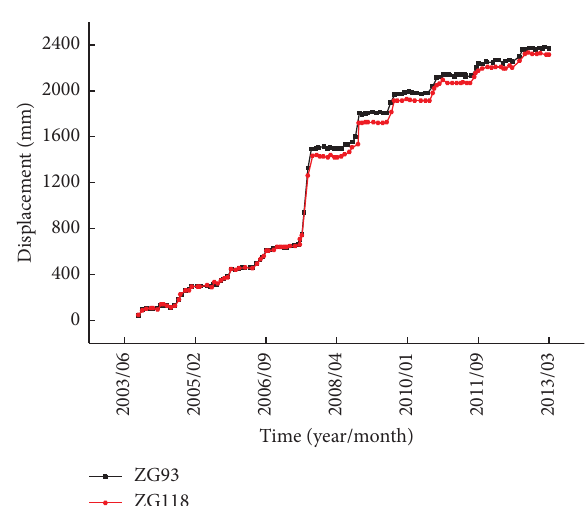
Figure 5: Observed displacements along with time in Baishuihe